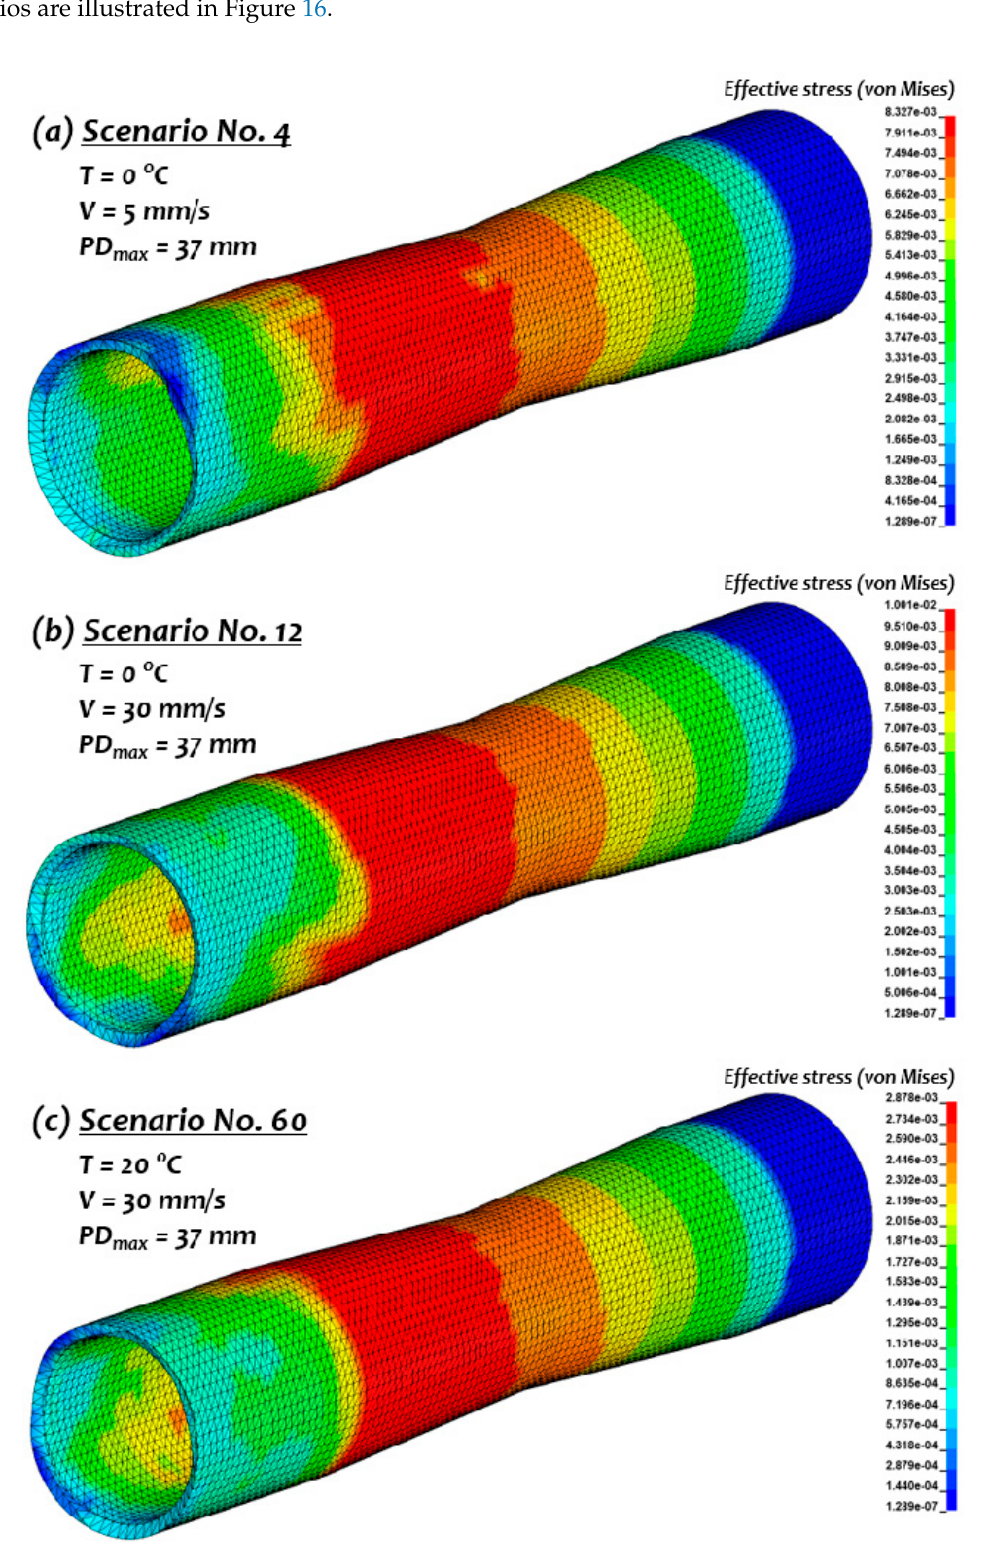
Figure 16. Stress contour plots of ( a ) scenario No. 4, ( b ) scenario No. 12, and ( c ) scenario No. 60 (Note: T = material temperature, V = velocity, and PD max = maximum plug diameter).